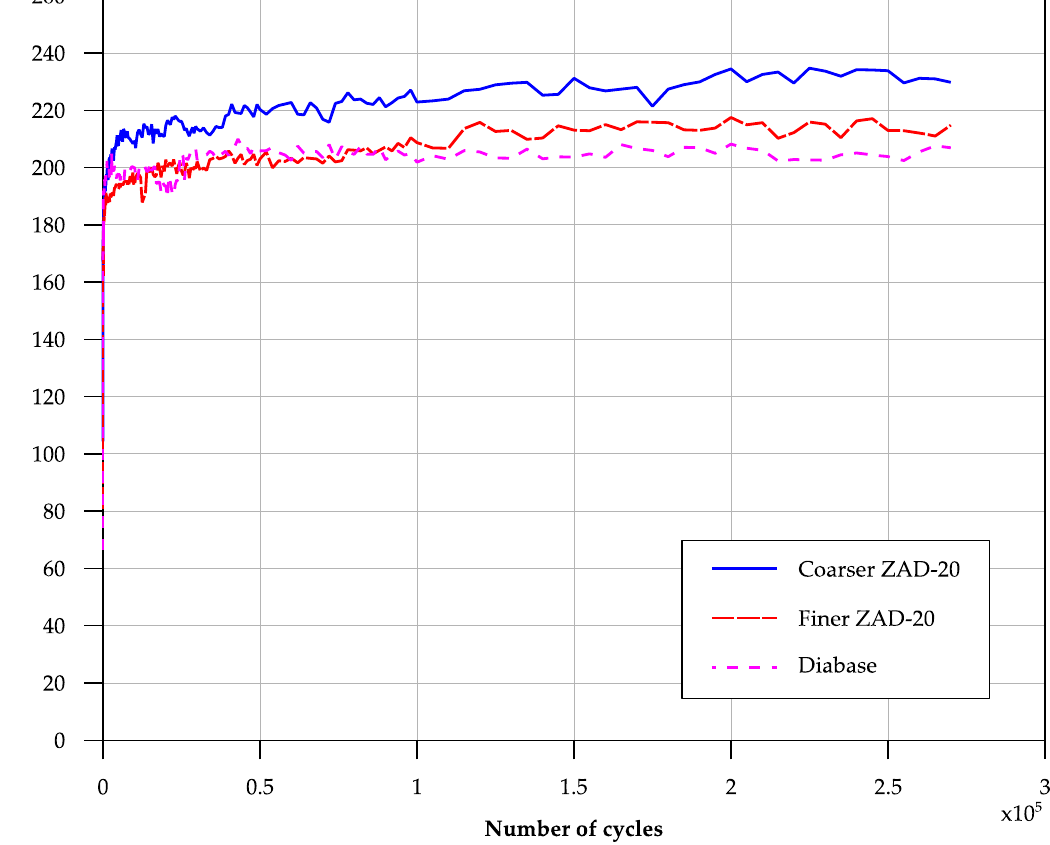
Table 3. Test cycles according to the material used.